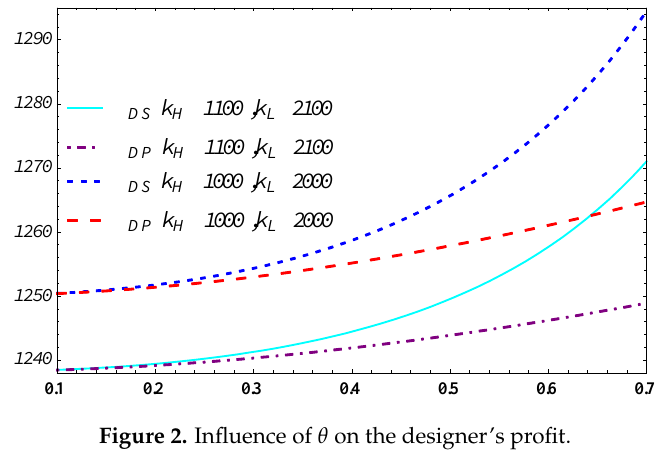
Figure 2. Influence of θ on the designer’s profit.